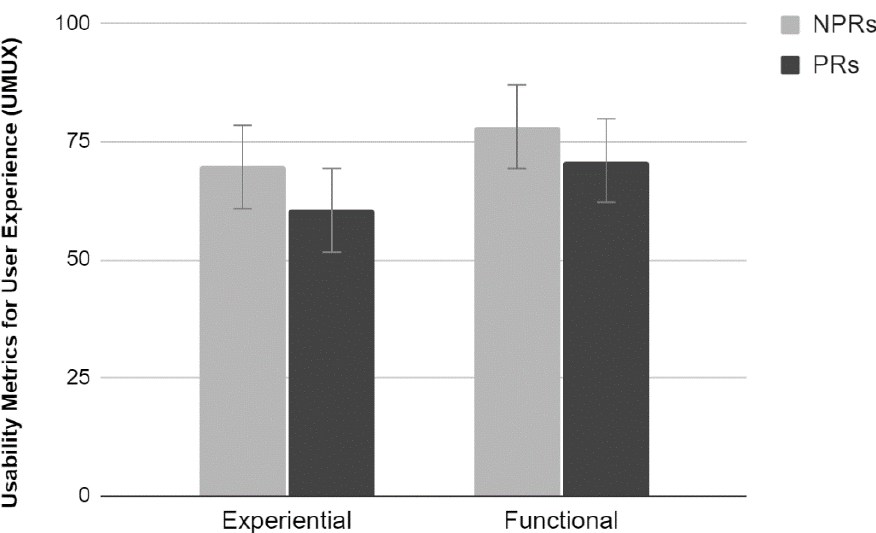
Figure 10. UMUX scale score by Experience (NPRs vs. PRs) and Test (Experiential vs. Functional). Error bars denote 0.95 confidence intervals.